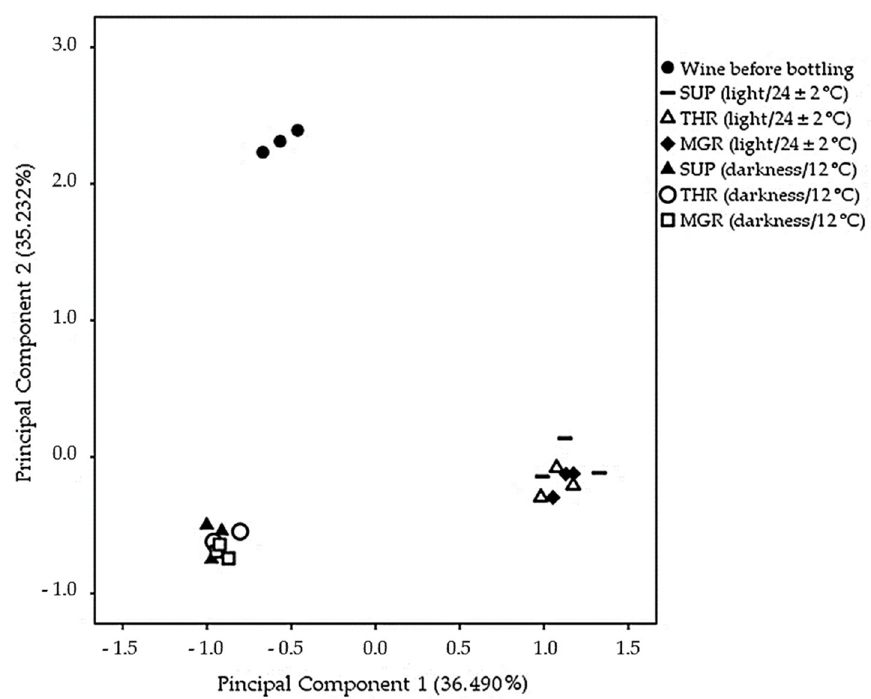
Figure 2. Plot of wines distributed in the space defining by principal components PC1 and PC2 regarding significant minor volatile compounds. SUP: super quality natural corks; THR: third quality natural corks; MGR: microgranulated corks.